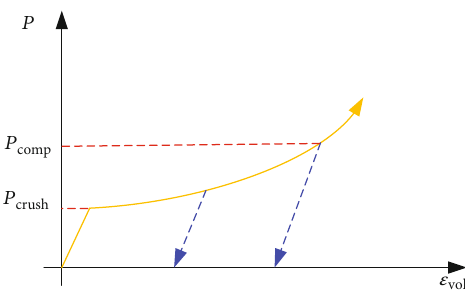
Figure 1: p- α EOS illustration in the RHT model.